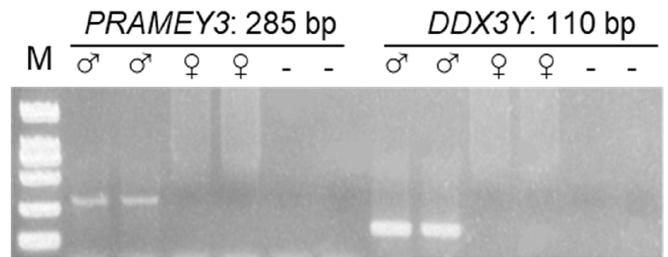
Figure 3. Gel electrophoresis of conventional PCR products of ovine PRAMEY3 and DDX3Y . The primers of these two Y-linked genes amplified male-specific bands with expected fragment sizes labeled above each band. M: 2 kb DNA ladder; ♂ : male sheep genomic DNA; ♀ : female sheep genomic DNA; − : negative control (distilled water).